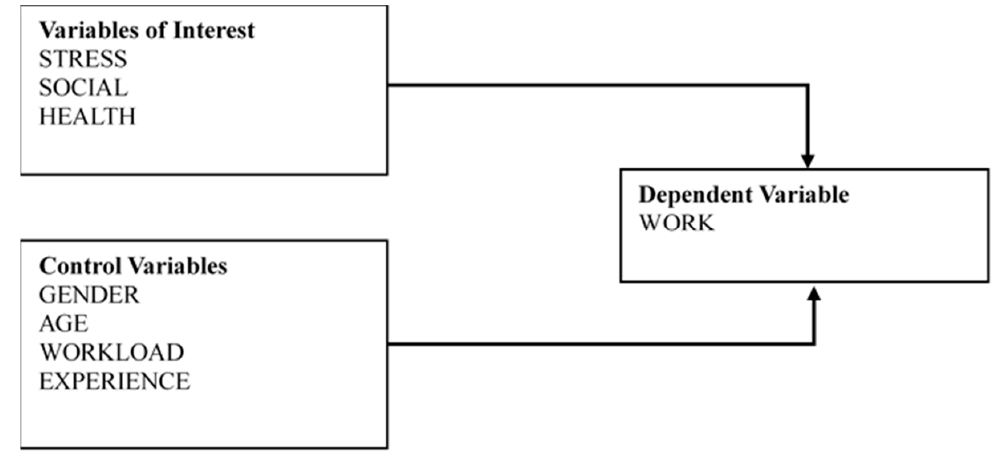
Table 2. Descriptive Statistics of